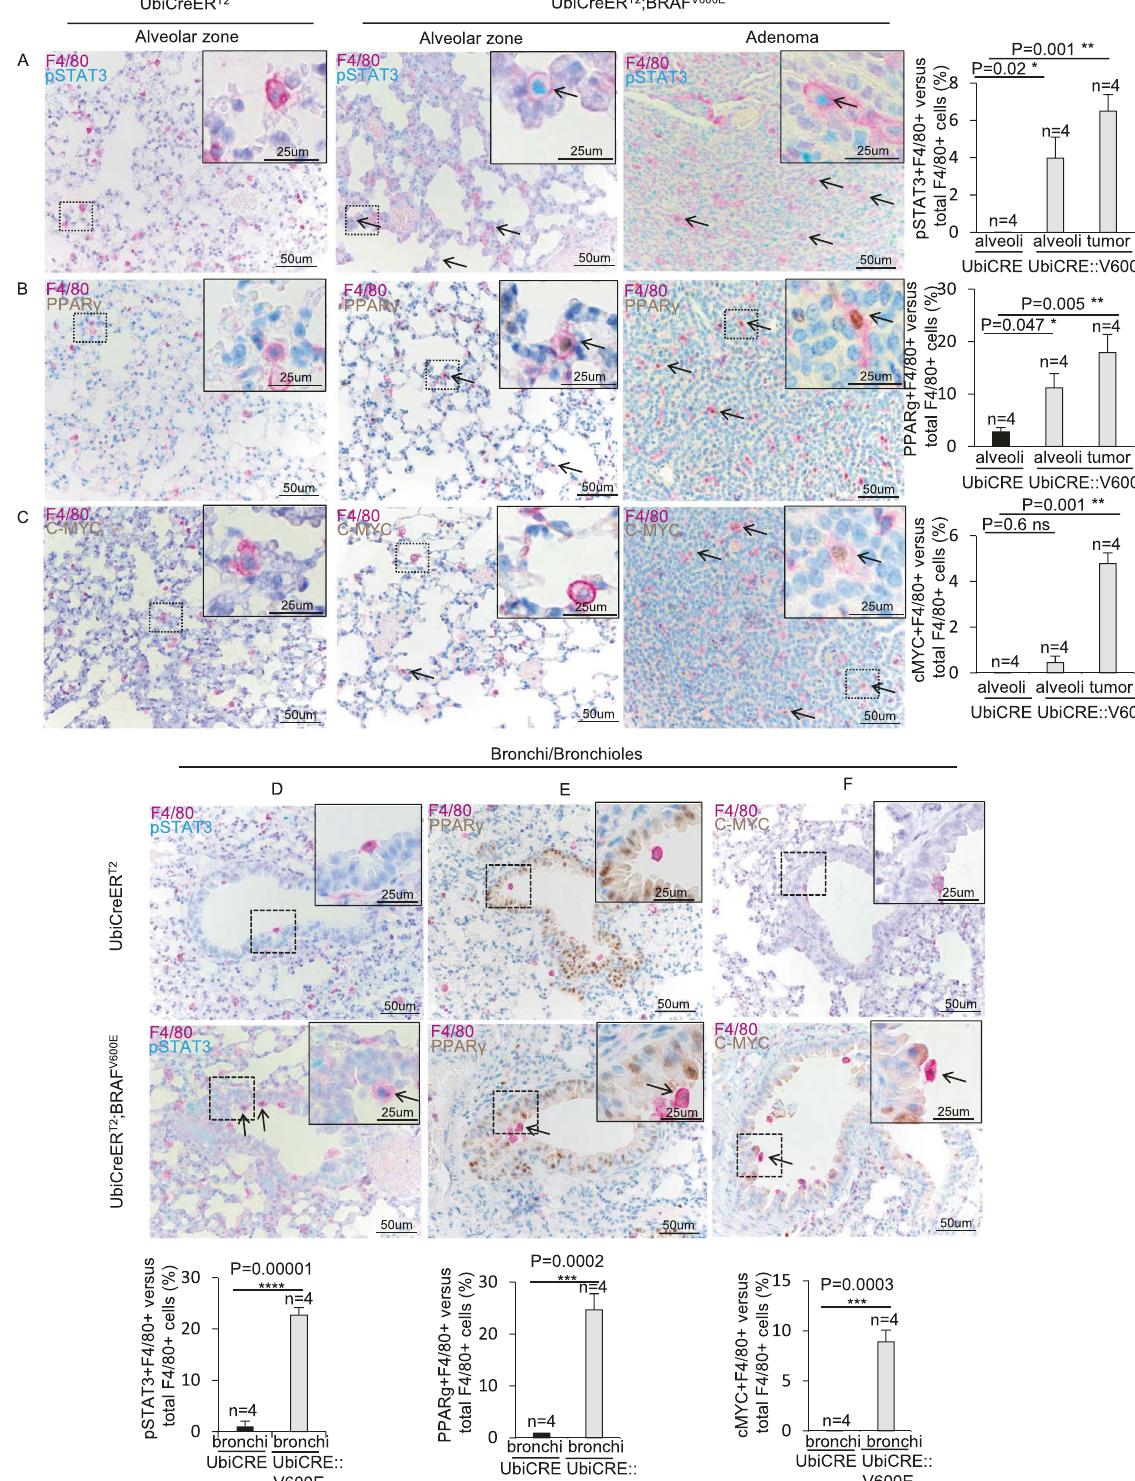
Fig. 7 BRAF V600E induction results in an overall M2-like macrophages increase in the lung. A – C Representative images (on the left) and quanti fi cations (on the right) showing F4/80 + cells staining positive for A pSTAT3, B PPAR γ , C c-MYC immunostainings in alveolar parenchyma and adenoma sections from BRAF V600E and control mice. D – F Representative images (top) and quanti fi cations (bottom) showing F4/80 + cells staining positive for D pSTAT3, E PPAR γ , F c-MYC double immunostainings in bronchi/bronchiolar parenchyma of lung sections from BRAF V600E and control mice. Quanti fi cations were performed on at least fi ve different areas of the lung sections in a random way. Data are expressed as mean ± SEM; n = animals per group. * P < 0.05; ** P < 0.01; *** P < 0.001, ns = not signi fi cant. (ANOVA test with Dunnet post-hoc correction ( A , B , C ), T Student ’ s test unpaired ( D , E , F )). Arrows point to selected positive cells for the indicated marker. Insets: magni fi cations of areas inside dashed